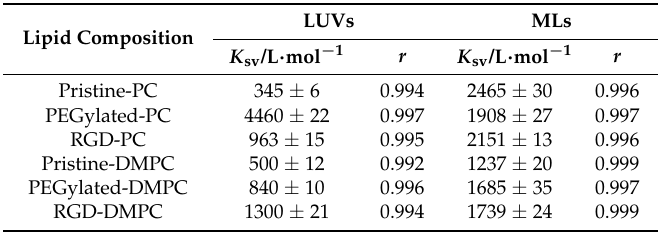
Table 3. K SV calculated from the fluorescence spectra of BSA upon increased additions of LUVs or MLs of different